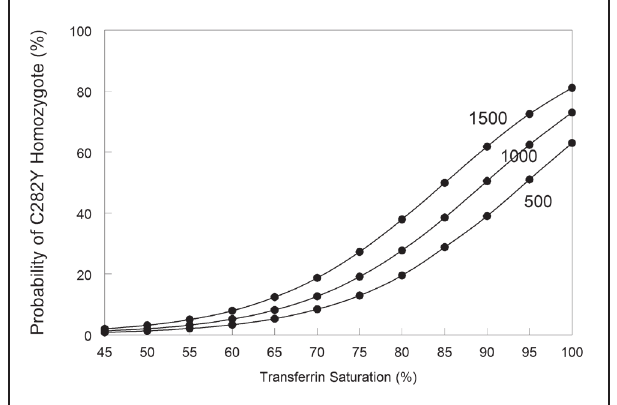
Figure 4) Probability of being a C282Y homozygote increases as serum trans- ferrin saturation increases in Caucasian men. The figure illustrates patients with serum ferritin levels of 500 µg/L, 1000 µg/L and 1500 µg/L. Data were generated from the Bernoulli regression equation for men from the